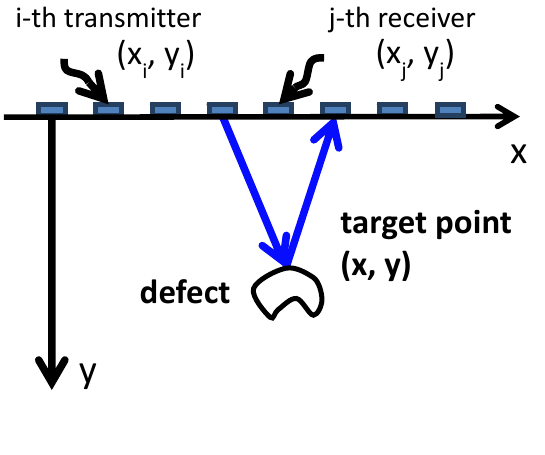
Figure 2. Schematic of TFM for pitch-catch signals of the i th transmitter and the j th